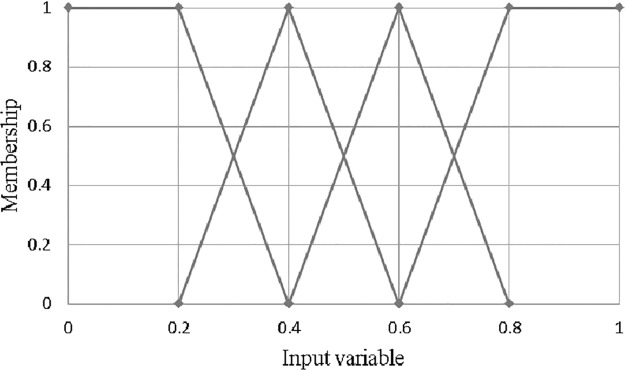
Membership function.